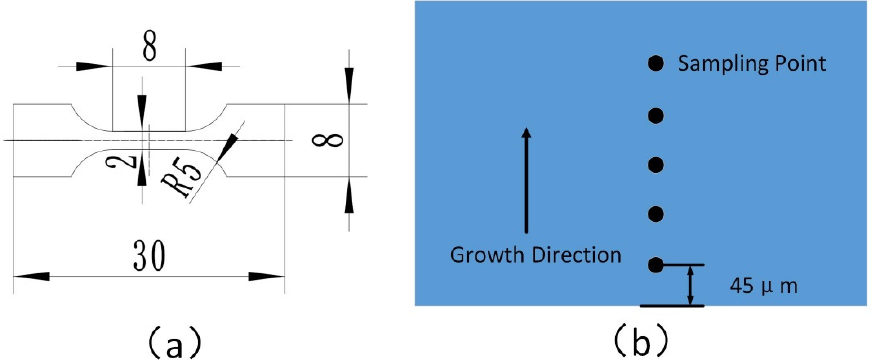
Figure 2. Standard tensile specimen pattern ( a ) and hardness testing schematic pattern ( b ). The sampling point will be marked every 45 µ m along the grain growth direction on the cross section of the copper sample for hardness testing, as shown in ( b ).